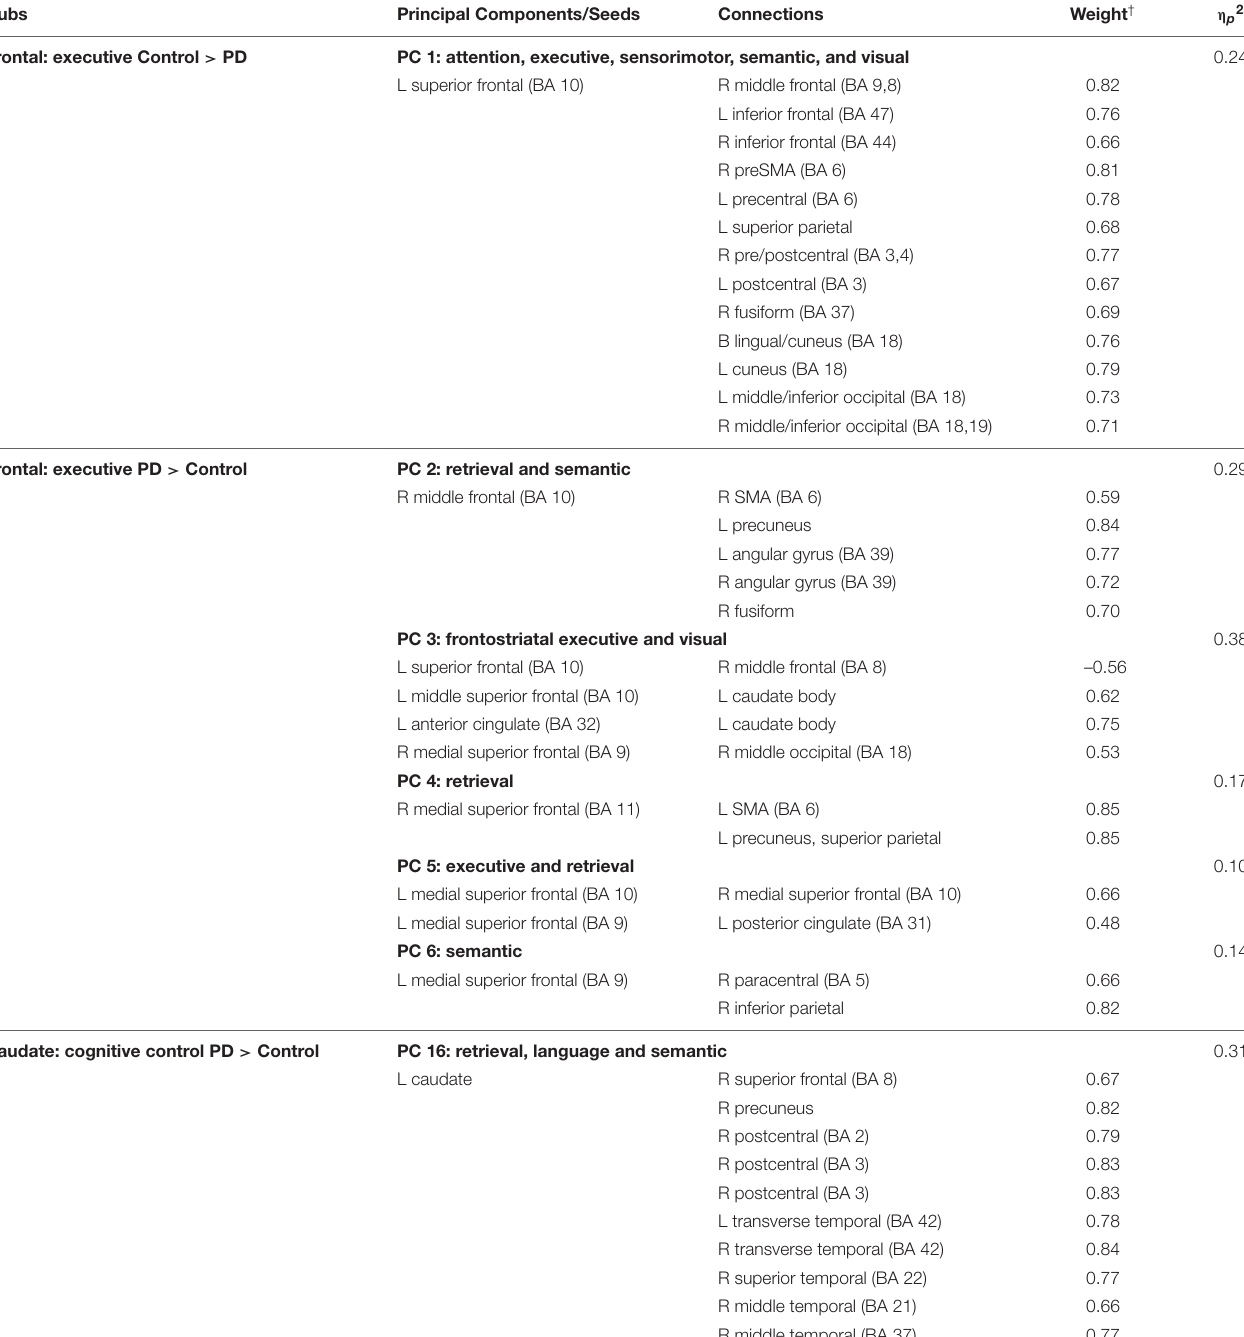
TABLE 3 | Principal components characterizing fame-modulated couplings of frontal and striatal regions of interest.